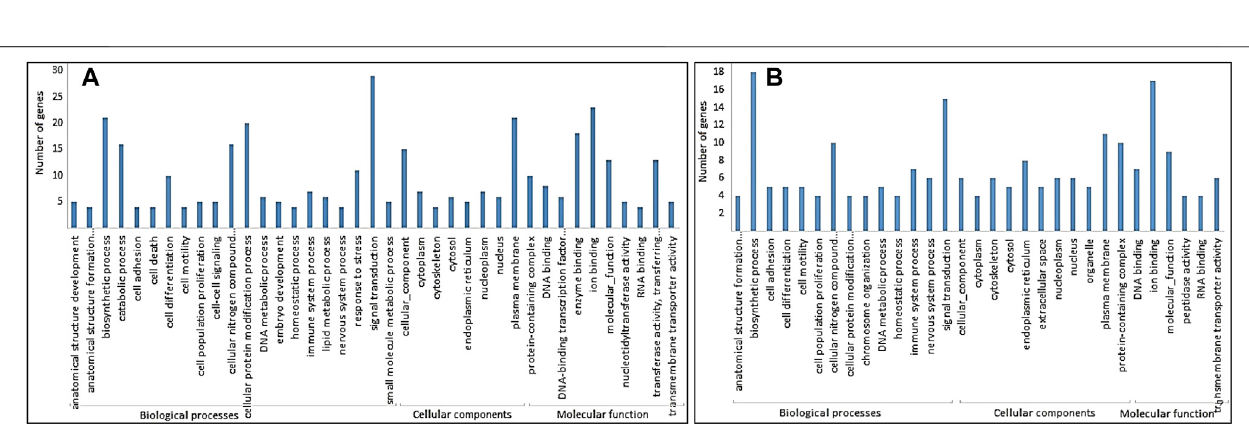
FIGURE 3 | GO terms in three classes: biological processes, cellular components, and molecular function for (A) hypomethylated DMGs and (B) hypermethylated DMGs.